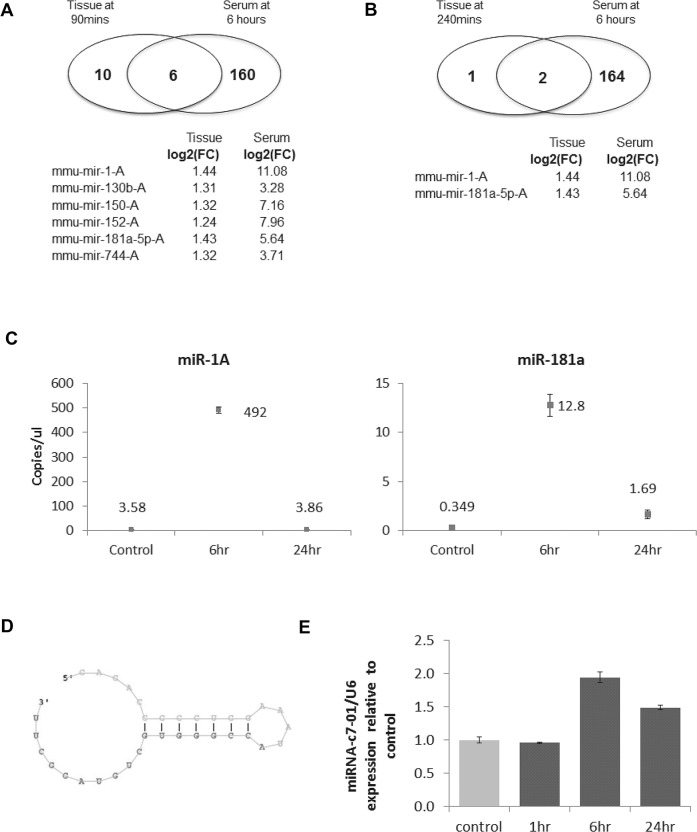
Circulating extracellular RNA after partial hepatectomy.(A and B) Comparison with tissue expression. miRNA expression was determined in liver tissues obtained at (A) 90 minutes and (B) 240 minutes after partial hepatectomy and were compared with miRNA detected in the serum six hours after partial hepatectomy. The Venn diagrams indicate miRNAs that had over 1.2 log-2 fold increase in both liver tissue and serum compared to baseline levels. The miRNA with the greatest increase in expression in both tissue and serum are indicated, with an increase in miR-1-A and miR 181a-5pA noted in hepatic tissue at both time points. (C) Quantitation by droplet digital PCR. A droplet digital PCR assay was used to analyze the expression of miR-1A, miR-181a-5p-A, and miR-222 in serum obtained at baseline, 6, and 24 hours after partial hepatectomy. exRNA was isolated from serum samples at each time point, treated with DNase, and reverse transcribed to obtain cDNA, and of which, 2ul was then emulsified into 1nL reaction droplets prior to target DNA amplification (40 cycles) performed using TaqMan miRNA assays. The fluorescence amplitude of each droplet was measured, and the target concentration (copies/ul) was calculated. No copies of miR-222 were detected. Data for other miRNAs represent merged data of mean quantitation from four technical replicates of one sample at each time point, with error bars showing the 95% confidence intervals after statistical analysis of positive and negative reactions based on poisson distribution. (D and E) Novel circulating extracellular miRNA. D. Putative miRNA with a genomic location mapped to chromosome 7 (pmiR-c7-01) identified by bioinformatics analysis of RNA sequencing data of circulating exRNA after partial hepatectomy. E. Serum expression of pmiR-c7-01 by qRT-PCR using custom- designed specific primers at indicated time points after partial hepatectomy.